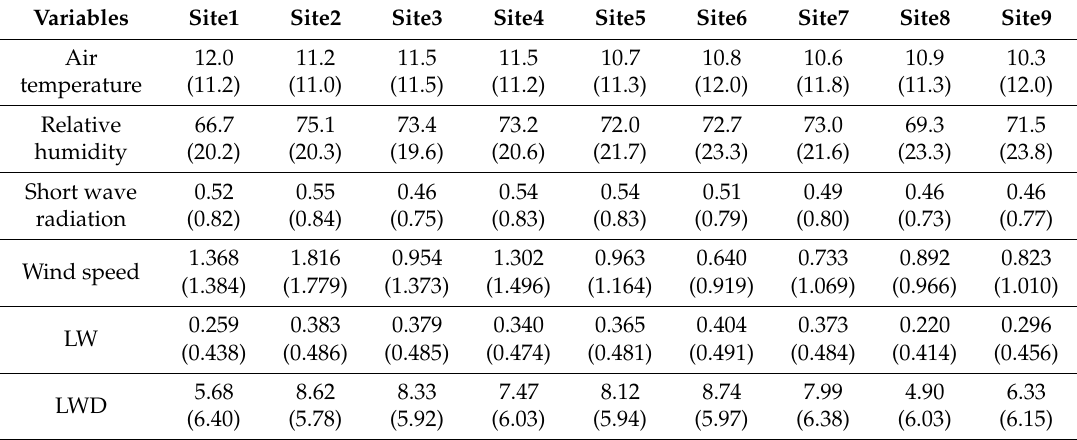
Figure 1. Locations of used meteorological sites. Table 2. Basic statistics of observed meteorological, leaf wetness (LW), and leaf wetness duration (LWD) data for the nine sites. Noted that the numbers in / out of the bracket are means and standard deviations,